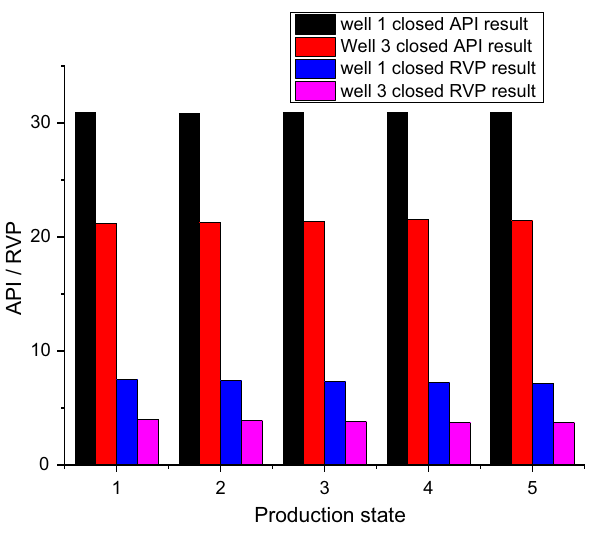
Fig. 10 Effect on API and RVP concerning various production states